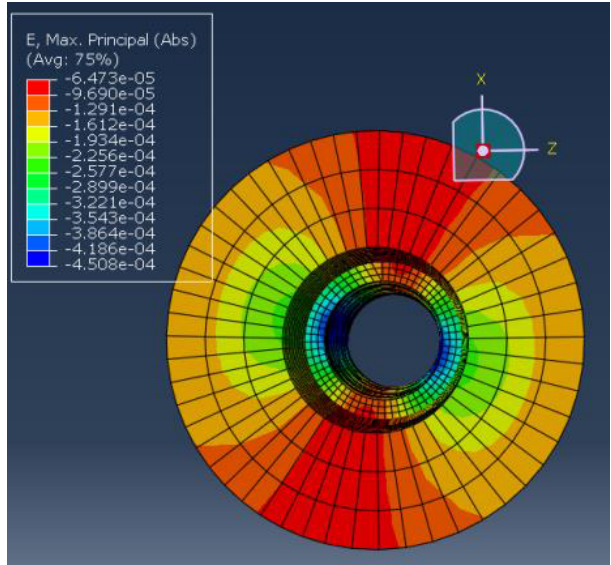
Figure 18. The deformation coupling between the epoxy resin layer and the hole wall.